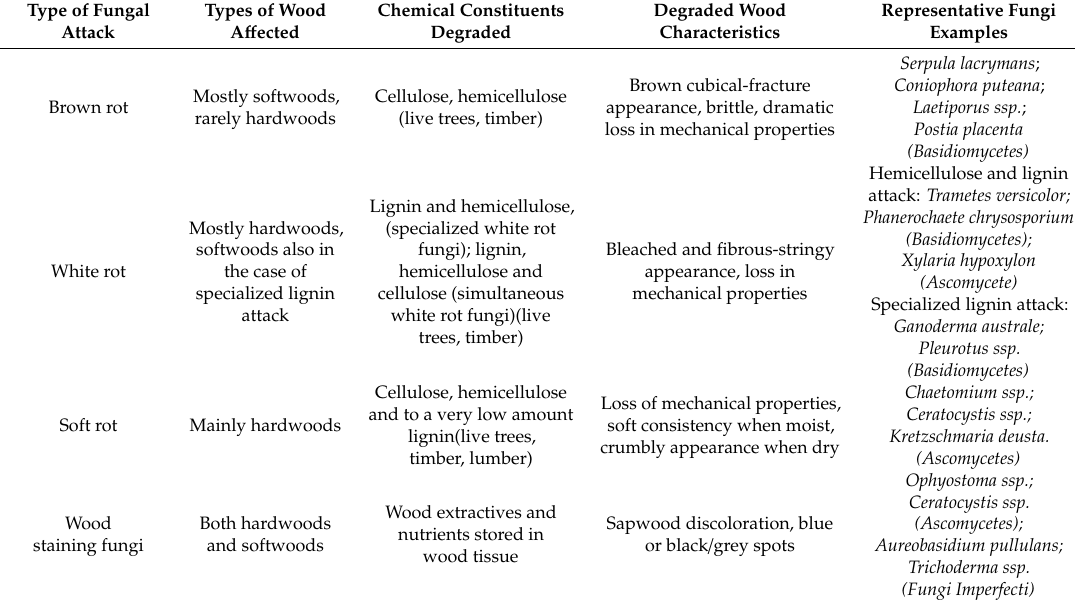
Table 1. Basic features of wood fungal attack